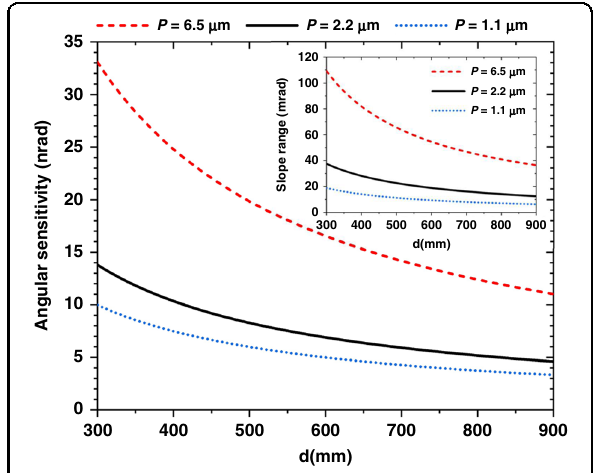
Fig. 11 Calculated angular sensitivity and slope range of SAM. The angular sensitivity and the corresponding slope measurement range (inset fi gure) of SAM as a function of the distance between the mirror surface and camera with different pixel size